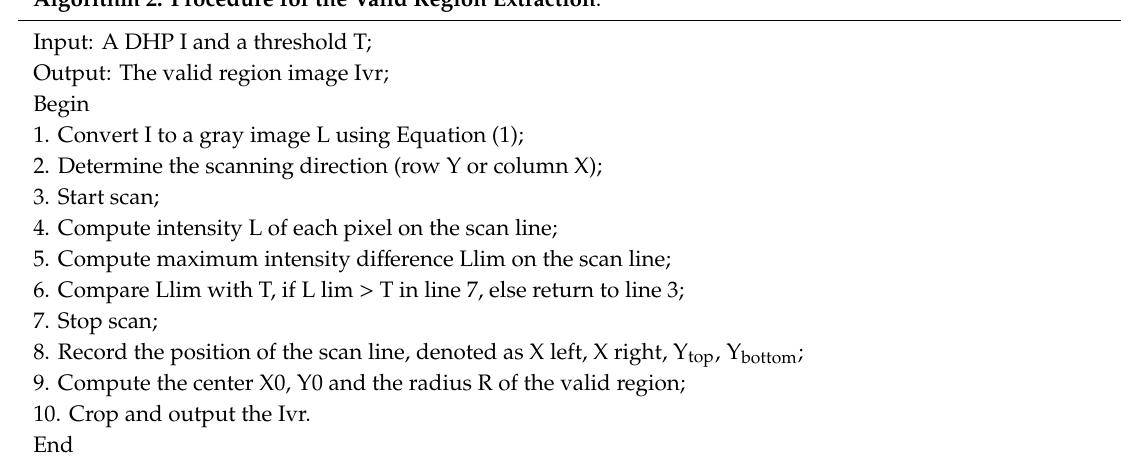
Algorithm 2. Procedure for the Valid Region Extraction.